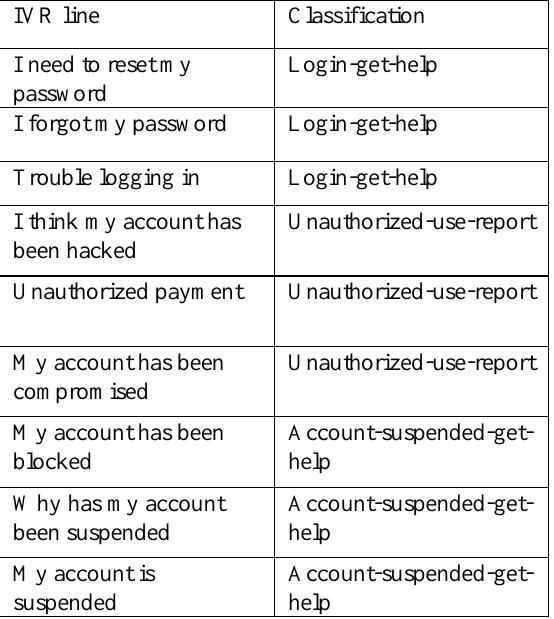
Table1. Sample lines with their labels